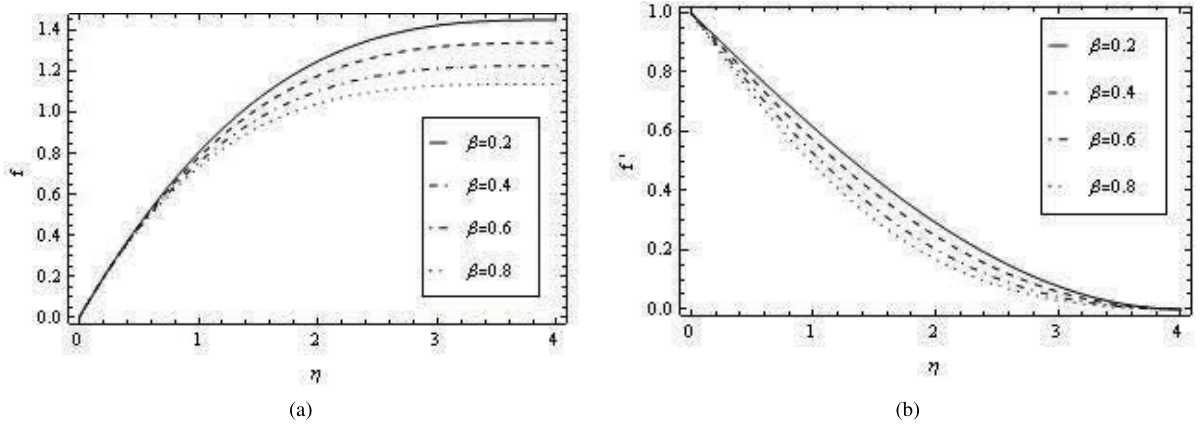
Figure 1. The influence of couple stress parameter ˇ when n D 0:5 on: (a) the stream function f .(cid:17)/ and (b) the velocity f 0 .(cid:17)/ .